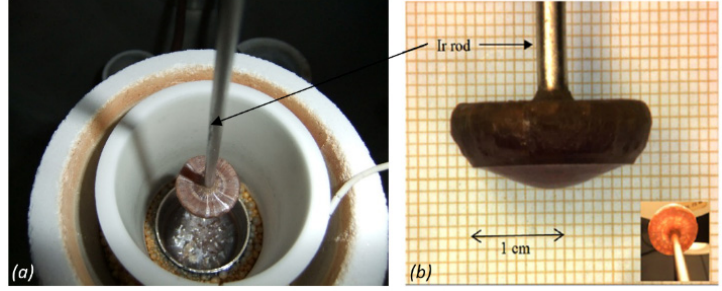
Figure 1. ( a ) (1 − x )BaTi 0.8 Zr 0.2 O 3 − x Ba 0.7 Ca 0.3 TiO 3 (BCTZ) as-grown boule in the inductively heated furnace with ceramics assembly for thermal insulation; and ( b ) as-grown centimeter sized BCTZ boule.